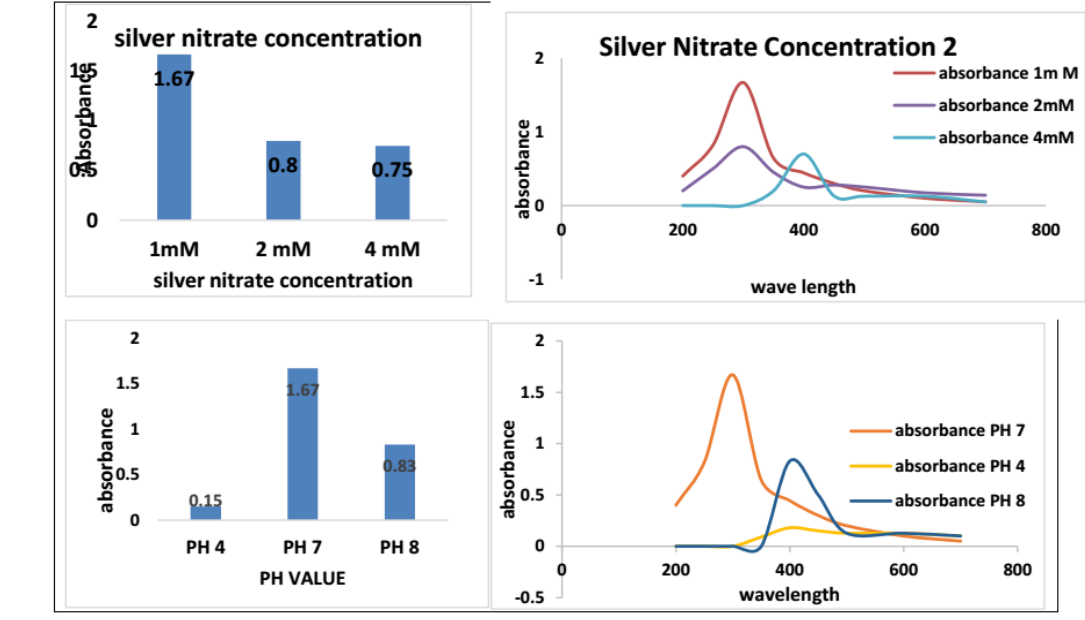
Figure 8. The optimization of nano particles synthesis by changing the silver nitrate concentration, by changing the final mixture PH.